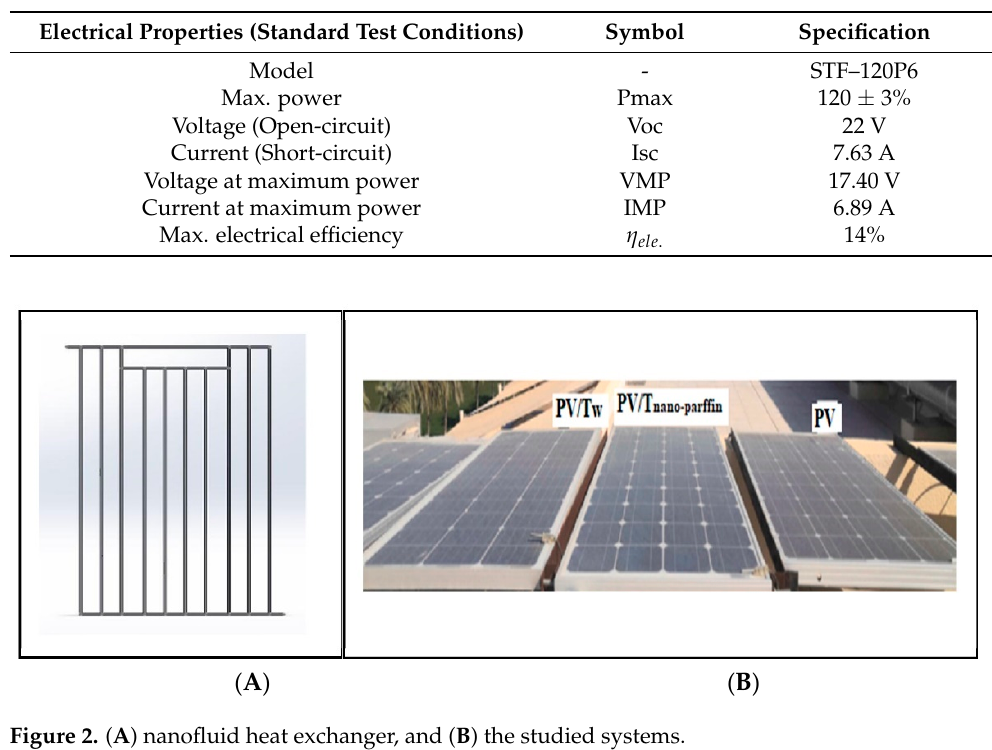
Table 2. Specifications of the PV modules used in the study.